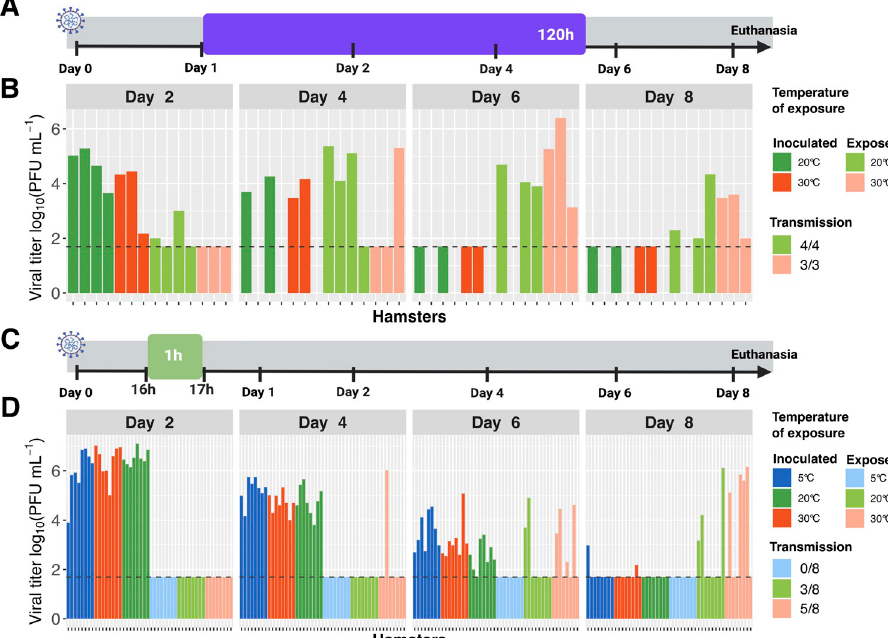
Fig 5. Low temperature does not promote SARS-CoV-2 transmission in hamsters. A, C] Schematic depicting experimental timeline. Animals were inoculated at Day 0 and exposures initiated at Day 1. Colored boxes show different exposure times, with the duration indicated within each box and the start times indicated with black ticks. B, D] Viral titers in nasal lavage samples collected from inoculated [dark colors] and exposed [light colors] hamsters are plotted. Facets show results from 2-, 4-, 6- and 8-days post-inoculation [dpi] with different colors indicating the temperature of exposure. A, B] Donor hamsters were inoculated with 1x10 4 PFU [titered on VeroE6 cells] and contacts were exposed for a period of five days under the indicated temperature conditions, beginning at 24 hpi. N = 4 transmission pairs. Comparison between 20˚C and 30˚C using Fisher’s exact test revealed that differences were not significant [P = 1.0]. C, D] Donor animals were inoculated with 1x10 2 PFU [titered on VeroE6 cells] and contacts were exposed for a period of one hour under the indicated temperature conditions, from 16–17 hpi. Data are combined from two independent experiments, giving a total of n = 8 transmission pairs. Comparison between 5˚C and 20˚C using Fisher’s exact test revealed that differences were not significant [P = 0.20]. Comparison between 20˚C and 30˚C using Fisher’s exact test revealed that differences were not significant [P = 0.62]. Comparison between 5˚C and 30˚C using Fisher’s exact test revealed that differences were statistically significant [P = 0.026]. Horizontal dashed line indicates limit of detection [50 PFU]. Missing data indicate that the animal died or was euthanized mid-way through the experiment. RH was 50% for all experiments